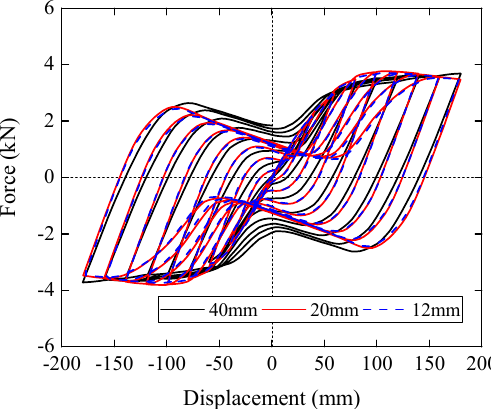
Figure 7. Hysteresis curves of models with different element sizes.